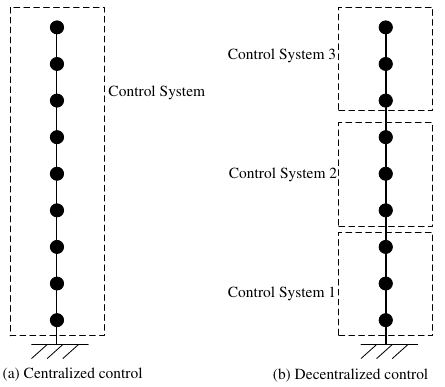
Figure 4. Schematic diagram of the control system of a 9-floor building